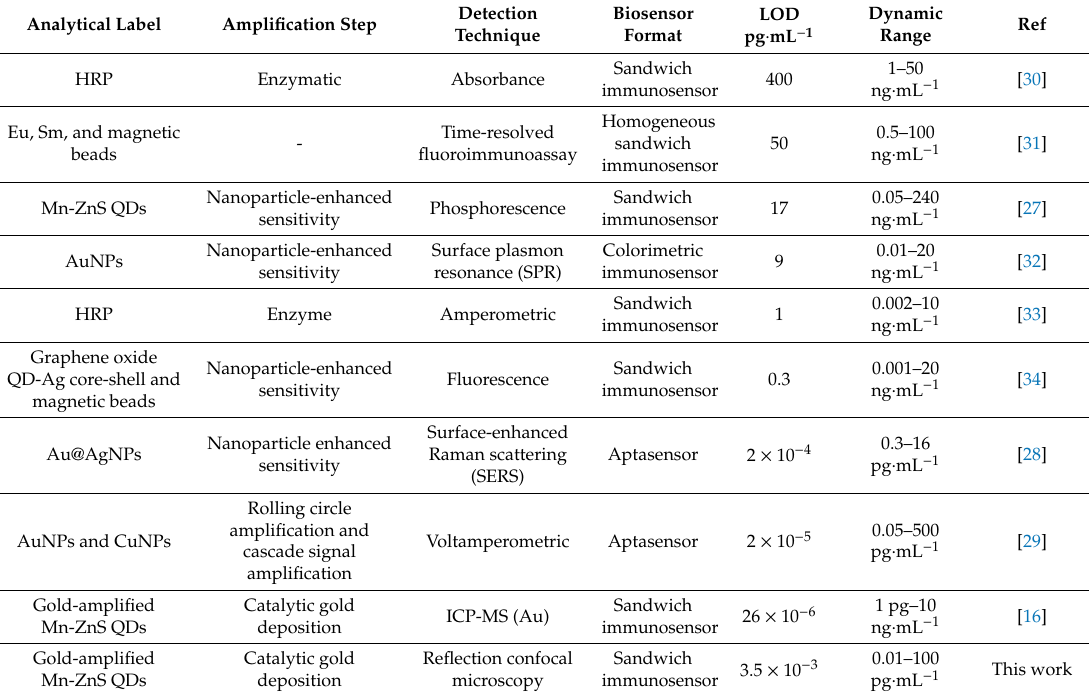
Table 1. Analytical performance characteristics of different biosensors for ultrasensitive PSA detection.